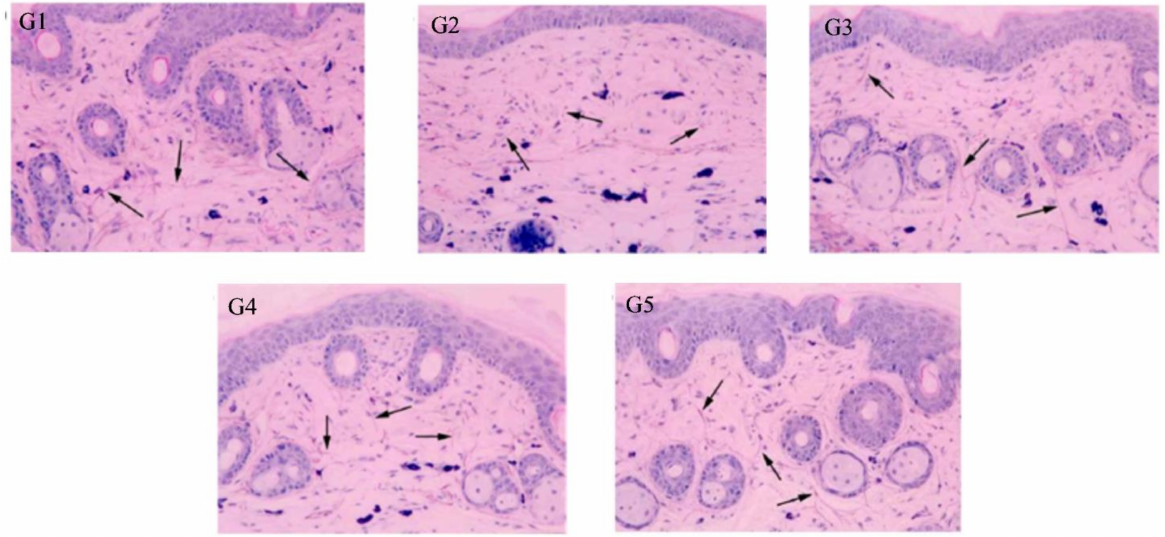
Figure 8. Histological observation of mice skin stained with hematoxylin-eosin. G2 showed a significant decline in elastic fibers compared to G1 . Treated groups had enhanced elasticity compared to G2 . All treated groups, G3-G5 showed enhanced elasticity. The arrow represents elastic fibers viewed at × 200